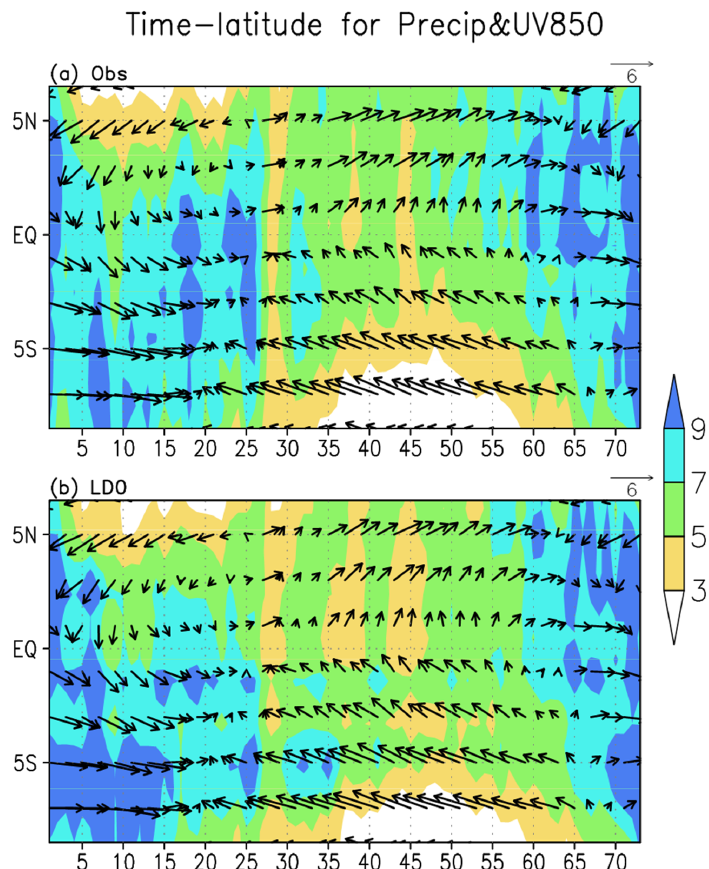
Figure 2. Time-latitude cross-sections of climatological pentad mean rainfall (GPCP; shadings; mm/day) and 850-hPa winds (CFSR; vectors; m/s) along the longitudes (98°E–145°E for 9°S–1°S and 98°E–120°E for 1°S–7°N) of Maritime Continent from the first pentad to the 73rd pentad (x-coordinate) for ( a ) observations; and ( b ) CFSv2 LD0 prediction.